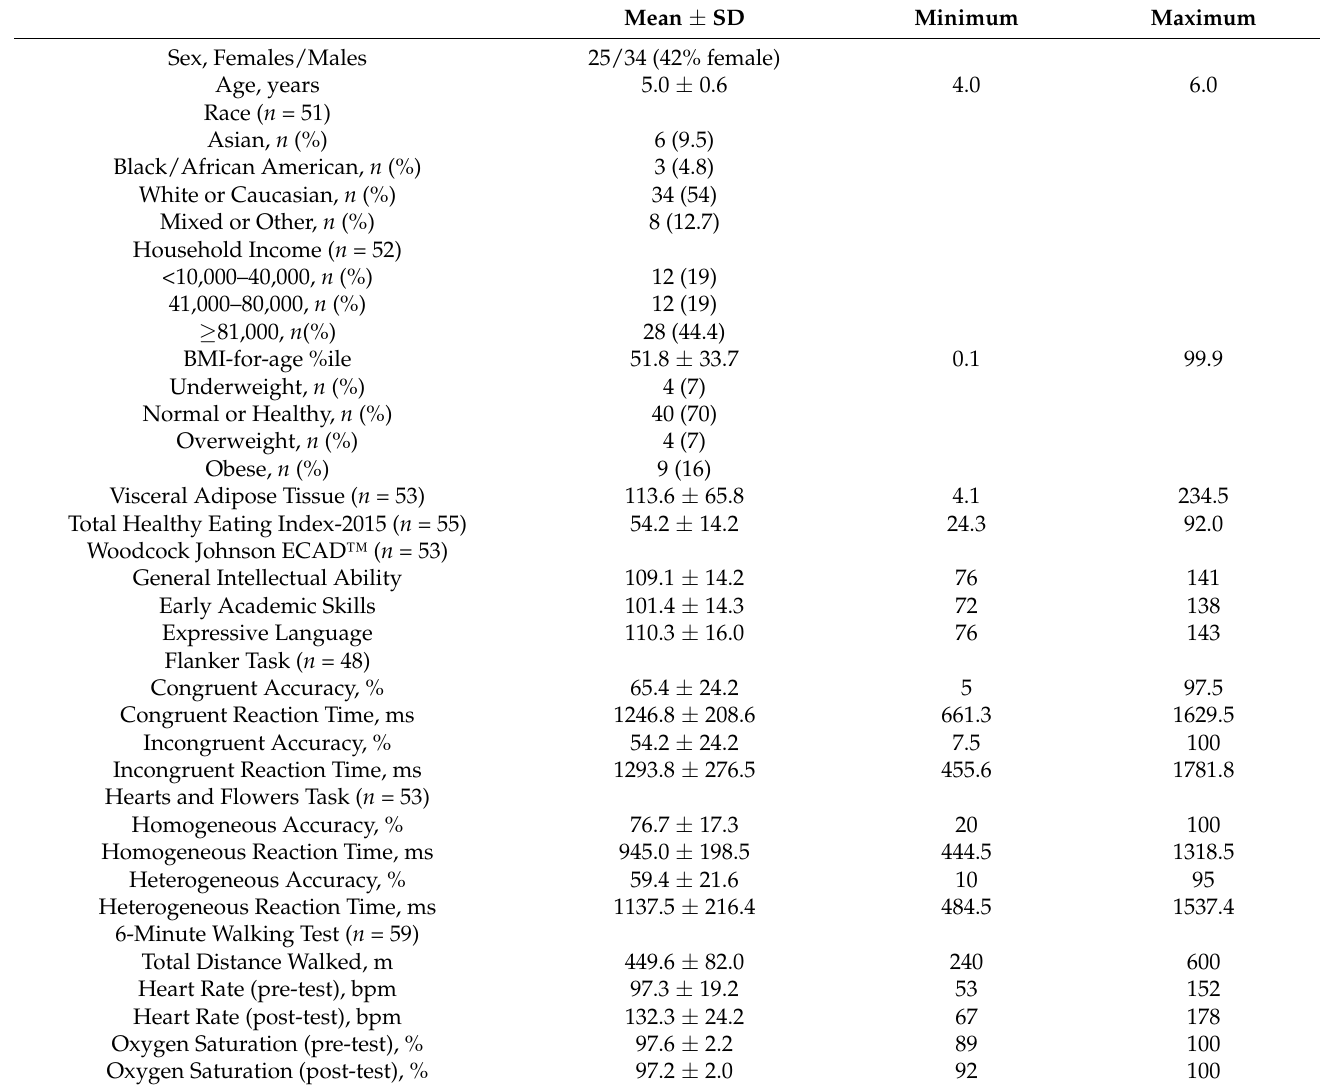
Table 1. Descriptive summary of main sample participant characteristics, diet, and task